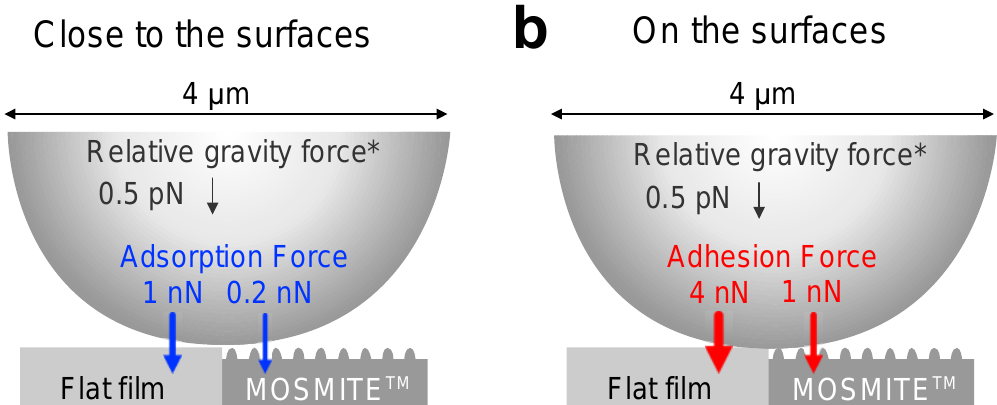
Figure 5. Summary of the forces lodging a 4- µ m particle. An approximate value is shown for each force. ( a ), A sphere coming close to the surface of the flat film and MOSMITE™. ( b ), A sphere adhering to the surfaces. *, Values for kaolinite.